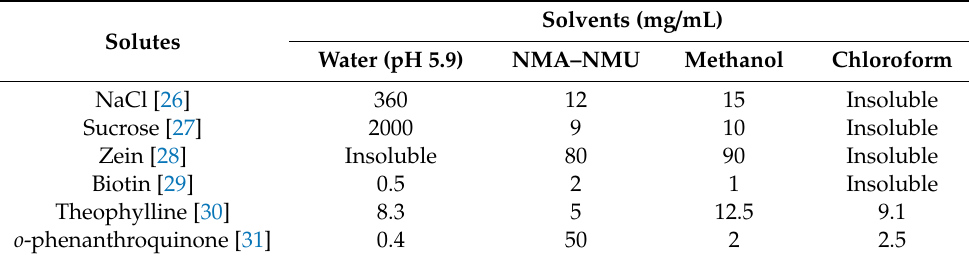
Table 3. Solubility of range of substance in NMA–NMU ni-DES compared to other solvents.